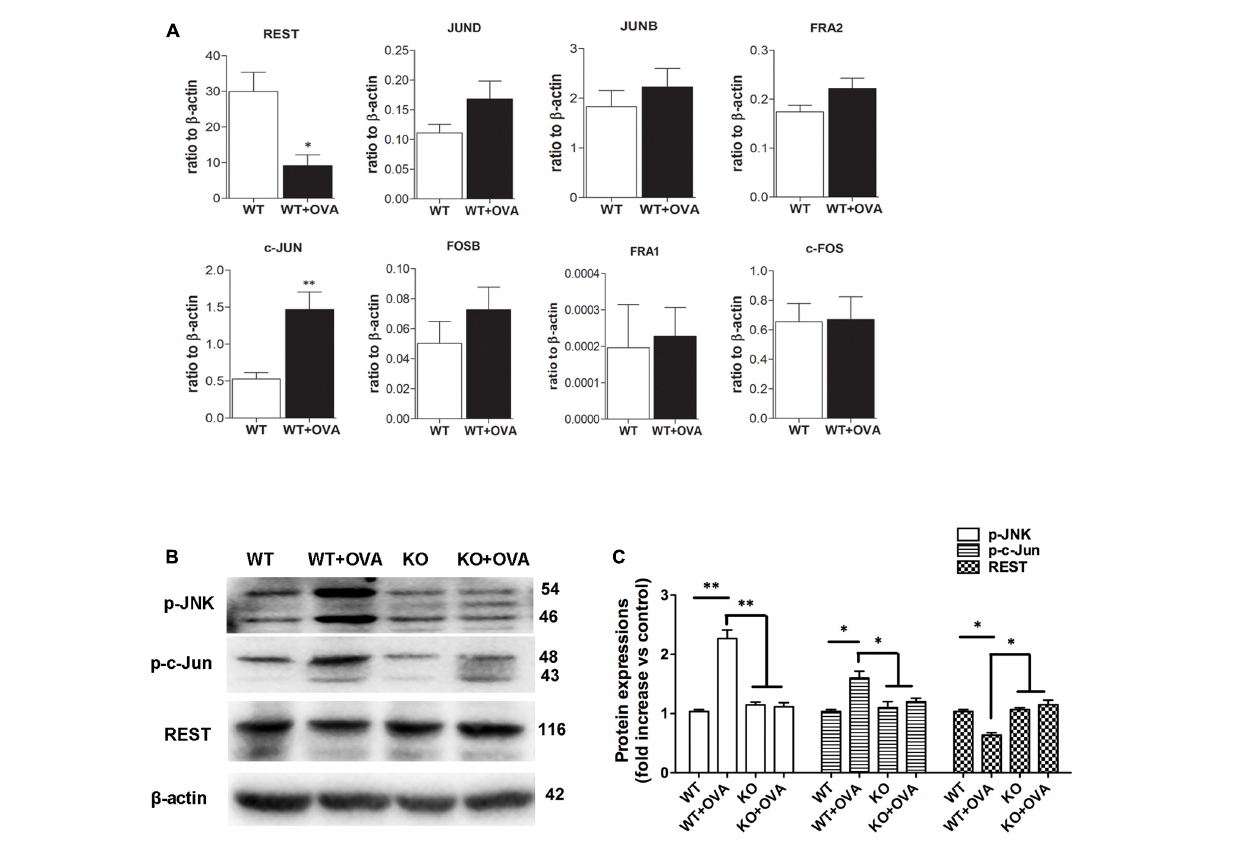
FIGURE 5 | Gene and protein expressions of REST and AP-1 components. (A) Real-time PCR analysis of REST, JunD, JunB, Fra2, c-Jun, FosB, Fra1, and c-Fos in WT and WT + OVA group mice. Values were shown for steady-state transcripts relative to β -actin. Data were presented as means ± SEM. ∗ p < 0.05, ∗∗ p < 0.01 versus WT group ( n = 5), Mann-Whitney test compared with WT mice. (B) p-JNK, p-c-Jun, and REST protein expressions in WT, WT + OVA, KO, and KO + OVA group mice. (C) Data were presented as means ± SEM. n = 5, ∗ p < 0.05, ∗∗ p < 0.01, one-way ANOVA followed by the Dunnett’s multiple comparison test compared with WT + OVA mice. WT, wildtype; KO,